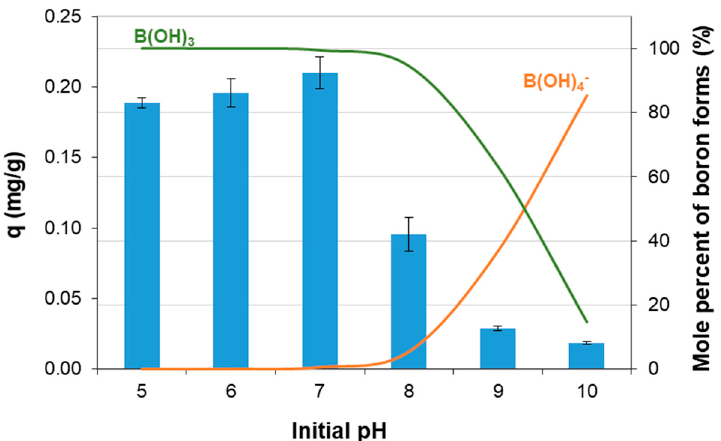
Figure 5. Boron sorption capacity (blue bars) and boron speciation (percentage of boric acid—green line, percentage of borate anion—orange line) as a function of initial pH value; mass of the Mn- biosorbent hydrogel beads: 1 g; initial concentration of boron: 20 mg/L; volume of solution: 10 mL; contact time: 48 h; temperature: 20 ± 1 °C.